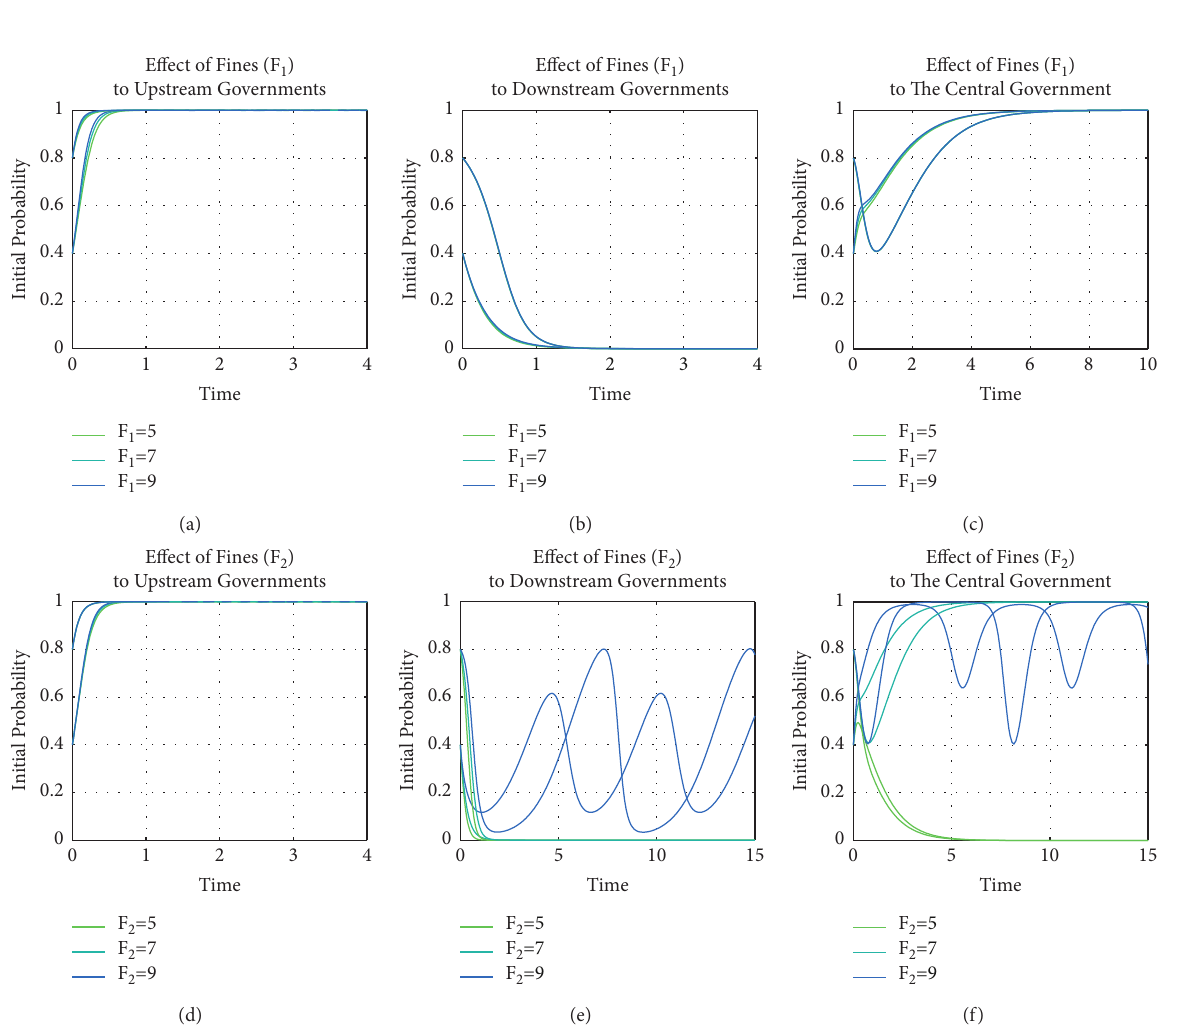
Figure 5: The effect of fines ( F and F ) on each player. (a) Effect of fines ( F 1 ) on upstream governments. (b) Effect of fines ( F 1 ) on 1 2 downstream governments. (c) Effect of fines ( F 1 ) on the central government. (d) Effect of fines ( F 2 ) on upstream governments. (e) Effect of fines ( F 2 ) on downstream governments. (f) Effect of fines ( F 2 ) on the central